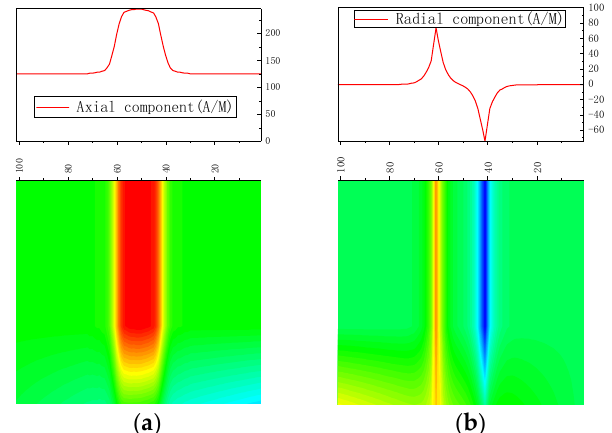
Figure 3. Results of welding stress simulation. ( a ) Welding stress diagram; ( b ) von Mises stress distribution diagram on the extracted y = 0 path.